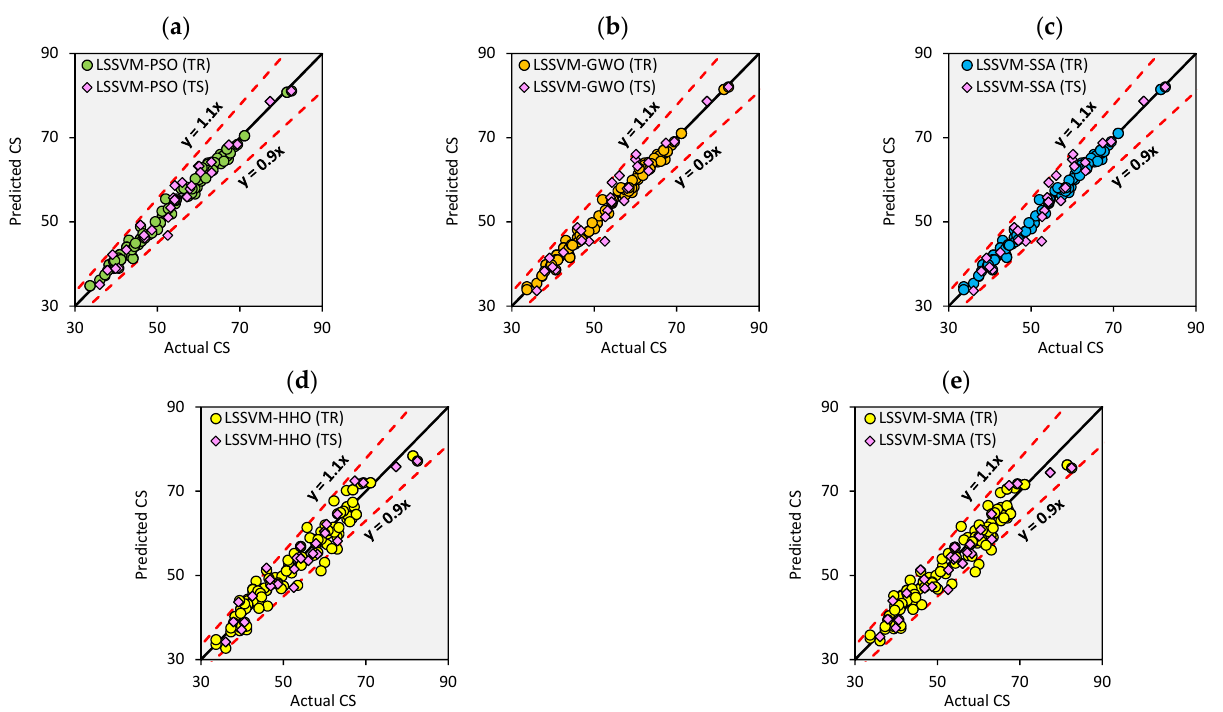
Figure 7. ( a – e ) Scatter plots between actual and predicted CS values for the training and testing